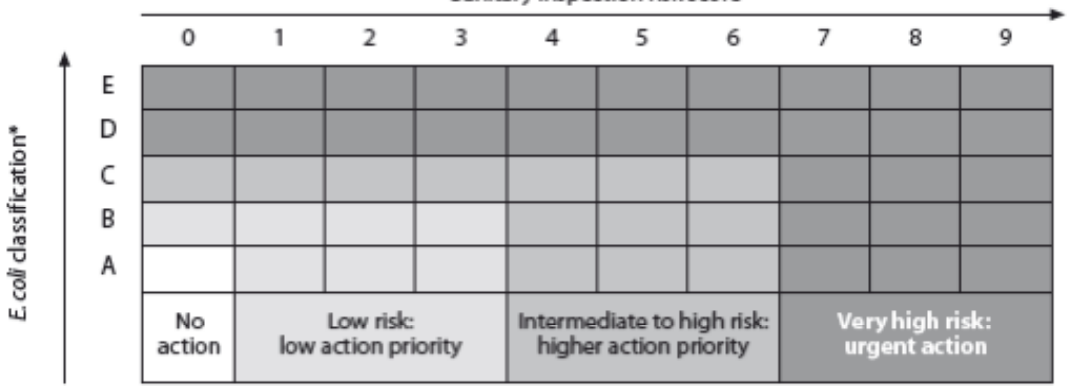
Figure 1. A Framework for Monitoring Water Quality & Sanitary Risk (Reprinted